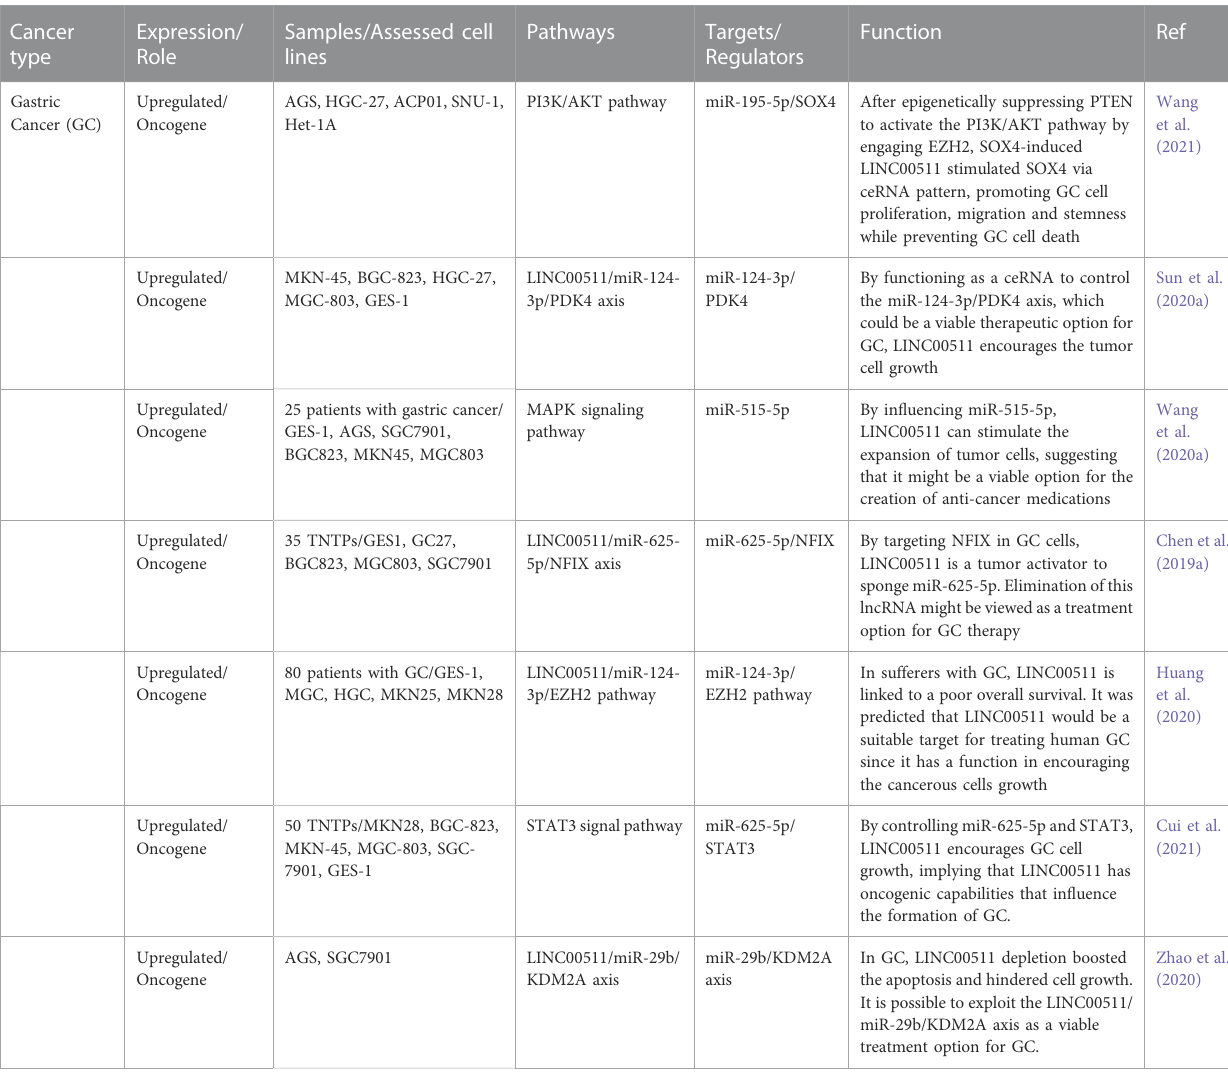
TABLE 2 Role of LINC00511 in gastric